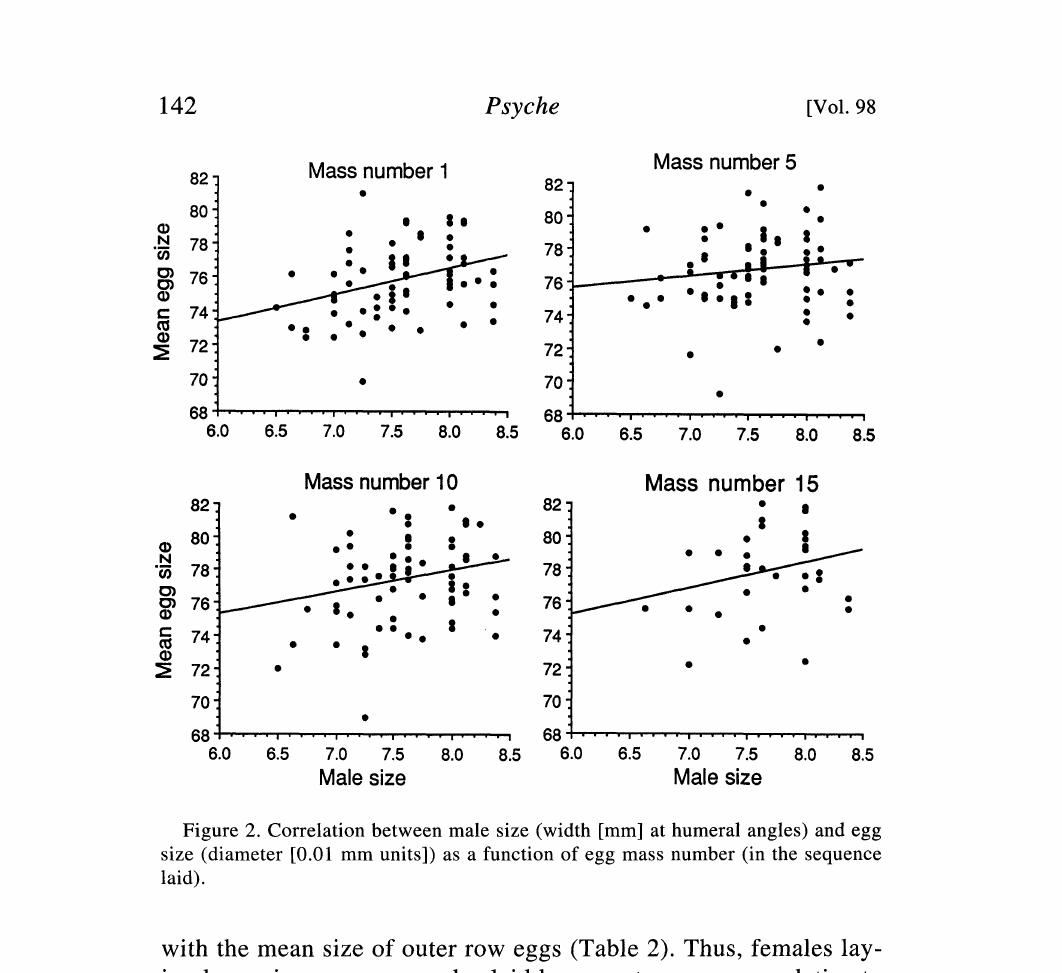
Figure 2. Correlation between male size (width [mm] at humeral angles) and egg size (diameter [0.01 mm units]) as a function of egg mass number (in the sequence